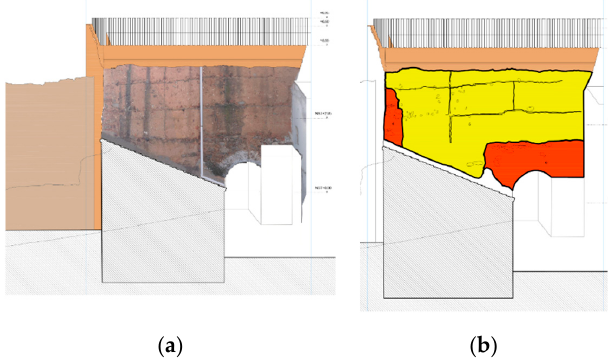
Figure 10. ( a ) Orthophoto of the rear façade. ( b ) Classification by elements.